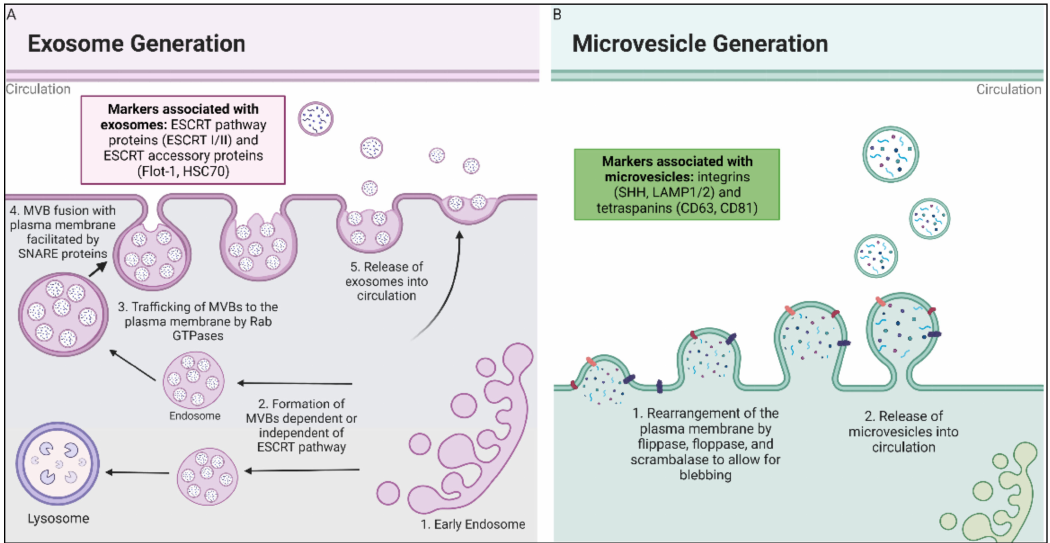
Figure 1. Biogenesis of exosomes and microvesicles. ( A ) Exosomes are derived from fusion of multi- vesicular endosomal bodies with the plasma membrane, which releases exosomes into extracellular space. Early endosomes are formed by the inward budding of either the plasma membrane or the Golgi Apparatus, where they then mature to late endosomes and become MVBs. The MVBs are then trafficked to the cell membrane, where they are fused with the plasma membrane by SNARE proteins [29,32,33]. ( B ) Microvesicles are formed by the rearrangement of the plasma membrane facilitated by flippase, floppase, scrambalase, and calpain, leading to the budding of the microvesicles from the cell membrane